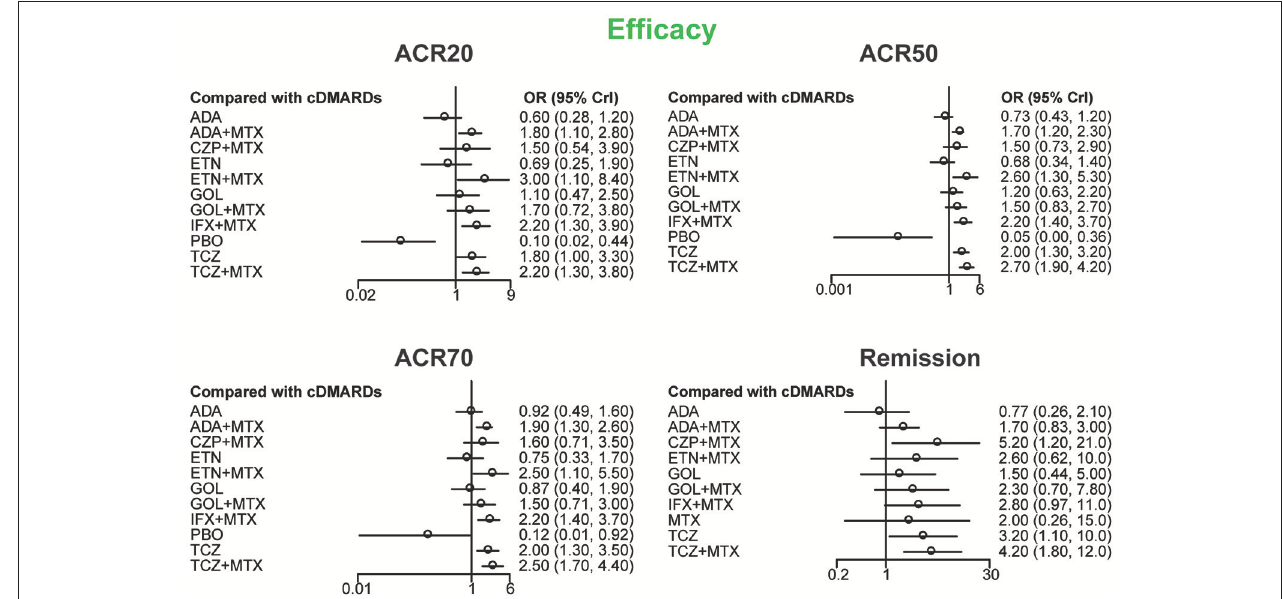
FIGURE 2 | The Odds ratio estimate with 95% credible intervals of efficacy endpoints compared to DMARDs.